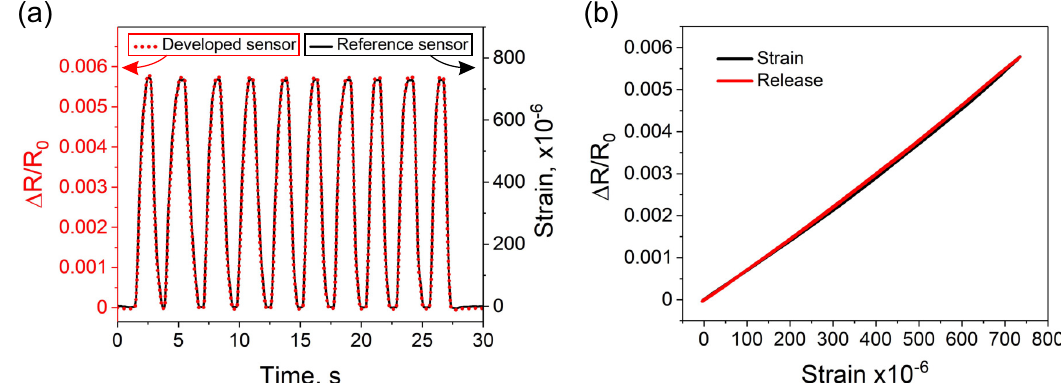
Figure 6. ( a ) Analysis of the developed strain sensor with the hybrid construction under cyclic deformations. The measured output signal from the developed sensor was compared to strain levels measured by the reference conventional strain sensor. ( b ) Analysis of the sensor with the hybrid construction intended to evaluate the linearity of the measured output signal and the presence of hysteresis. The plot shows 10 strain